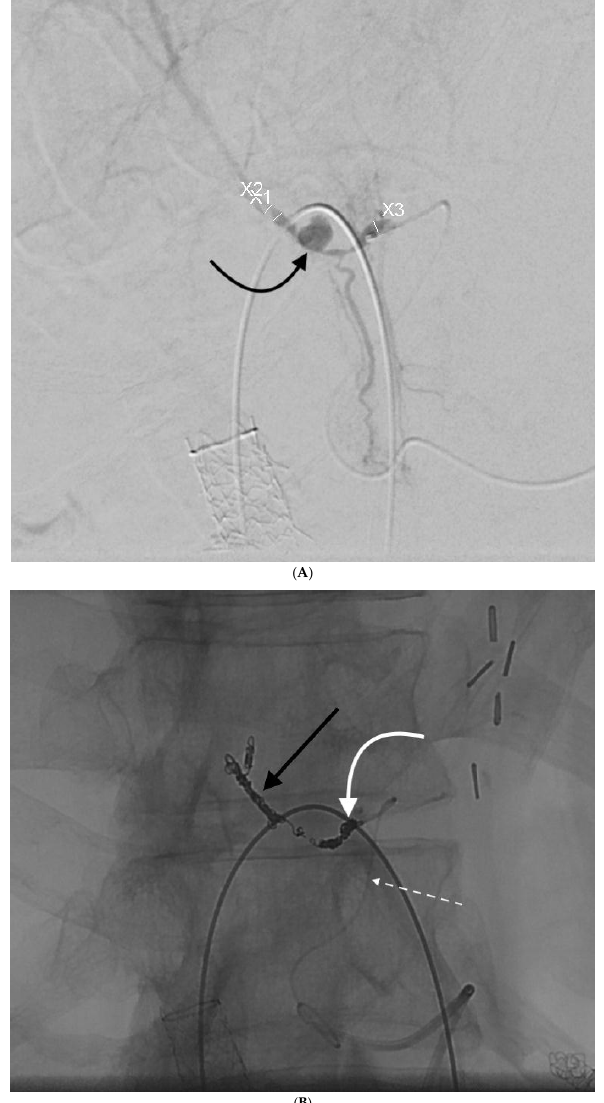
Figure 5. 58-year-old male with a pseudoaneurysm caused by PTBD that was treated with coil embolization. This patient had a history of ampullary carcinoma for which he underwent Whipple procedure complicated by bile leak at the choledochojejunostomy site. PTBD was placed with multiple subsequent episodes of hemobilia, which were initially treated with tube upsizing. ( A ) Angiogram 3 weeks after initial drain placement with drain removed over a wire showed a large pseudoaneurysm (curved black arrow) arising from the left hepatic artery. ( B ) Coils were placed distal (straight black arrow) and proximal (curved white arrow) to the pseudoaneurysm using a microcatheter (dashed white arrow). The hemobilia was successfully stopped.